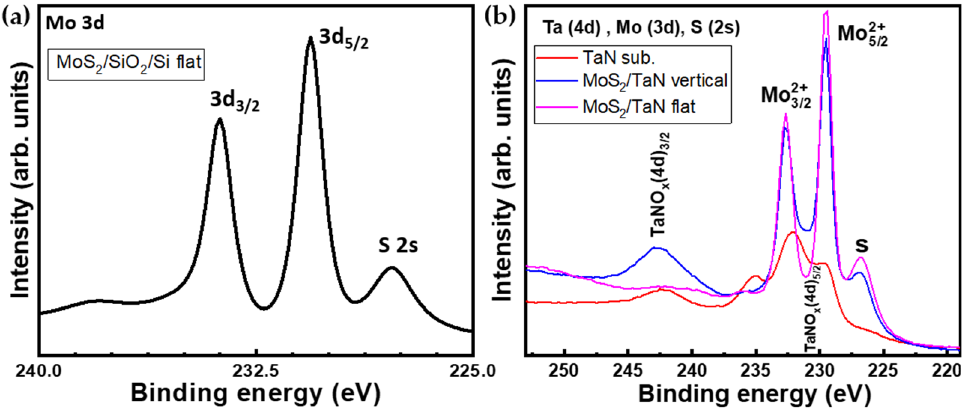
Figure 5. ( a ) XPS spectrum shows Mo(3d) and S(2p) core level regions of as-grown MoS 2 on SiO 2 /Si ( b ) XPS spectra of Ta(4d), Mo(3d) and S(2s) core level regions of as-grown vertical (blue) and flat (magenta) MoS 2 on TaN and bare TaN substrate (red).